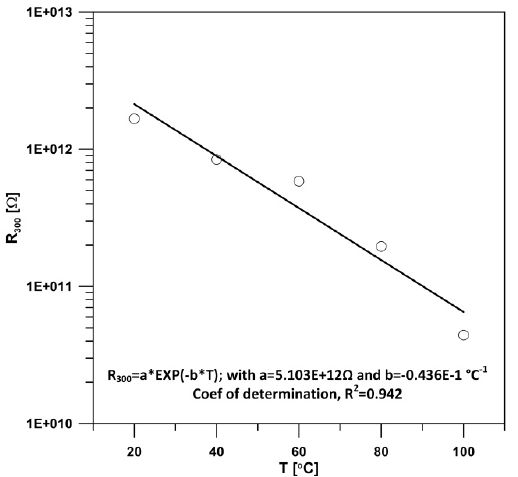
Figure 5. The influence of temperature on resistance of the non-aged aramid insulation sample impregnated with mineral insulating oil measured after 300 s.